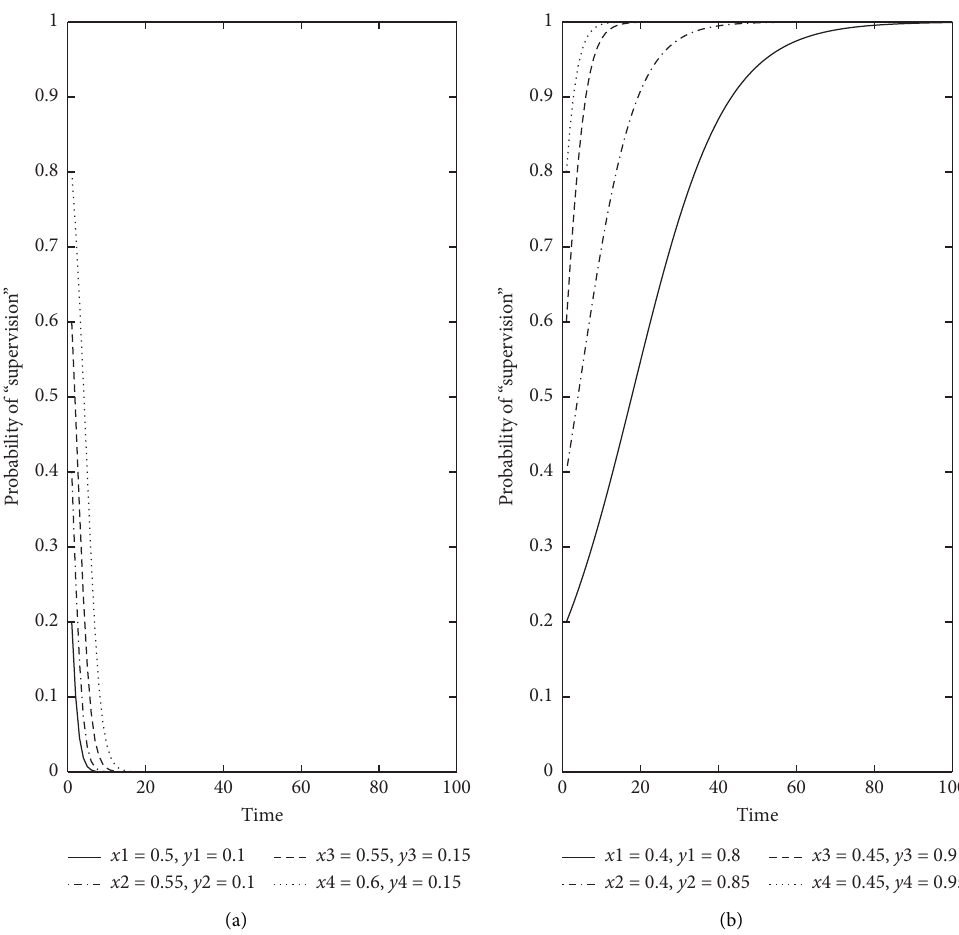
Figure 3: Evolutionary process of the government regulatory